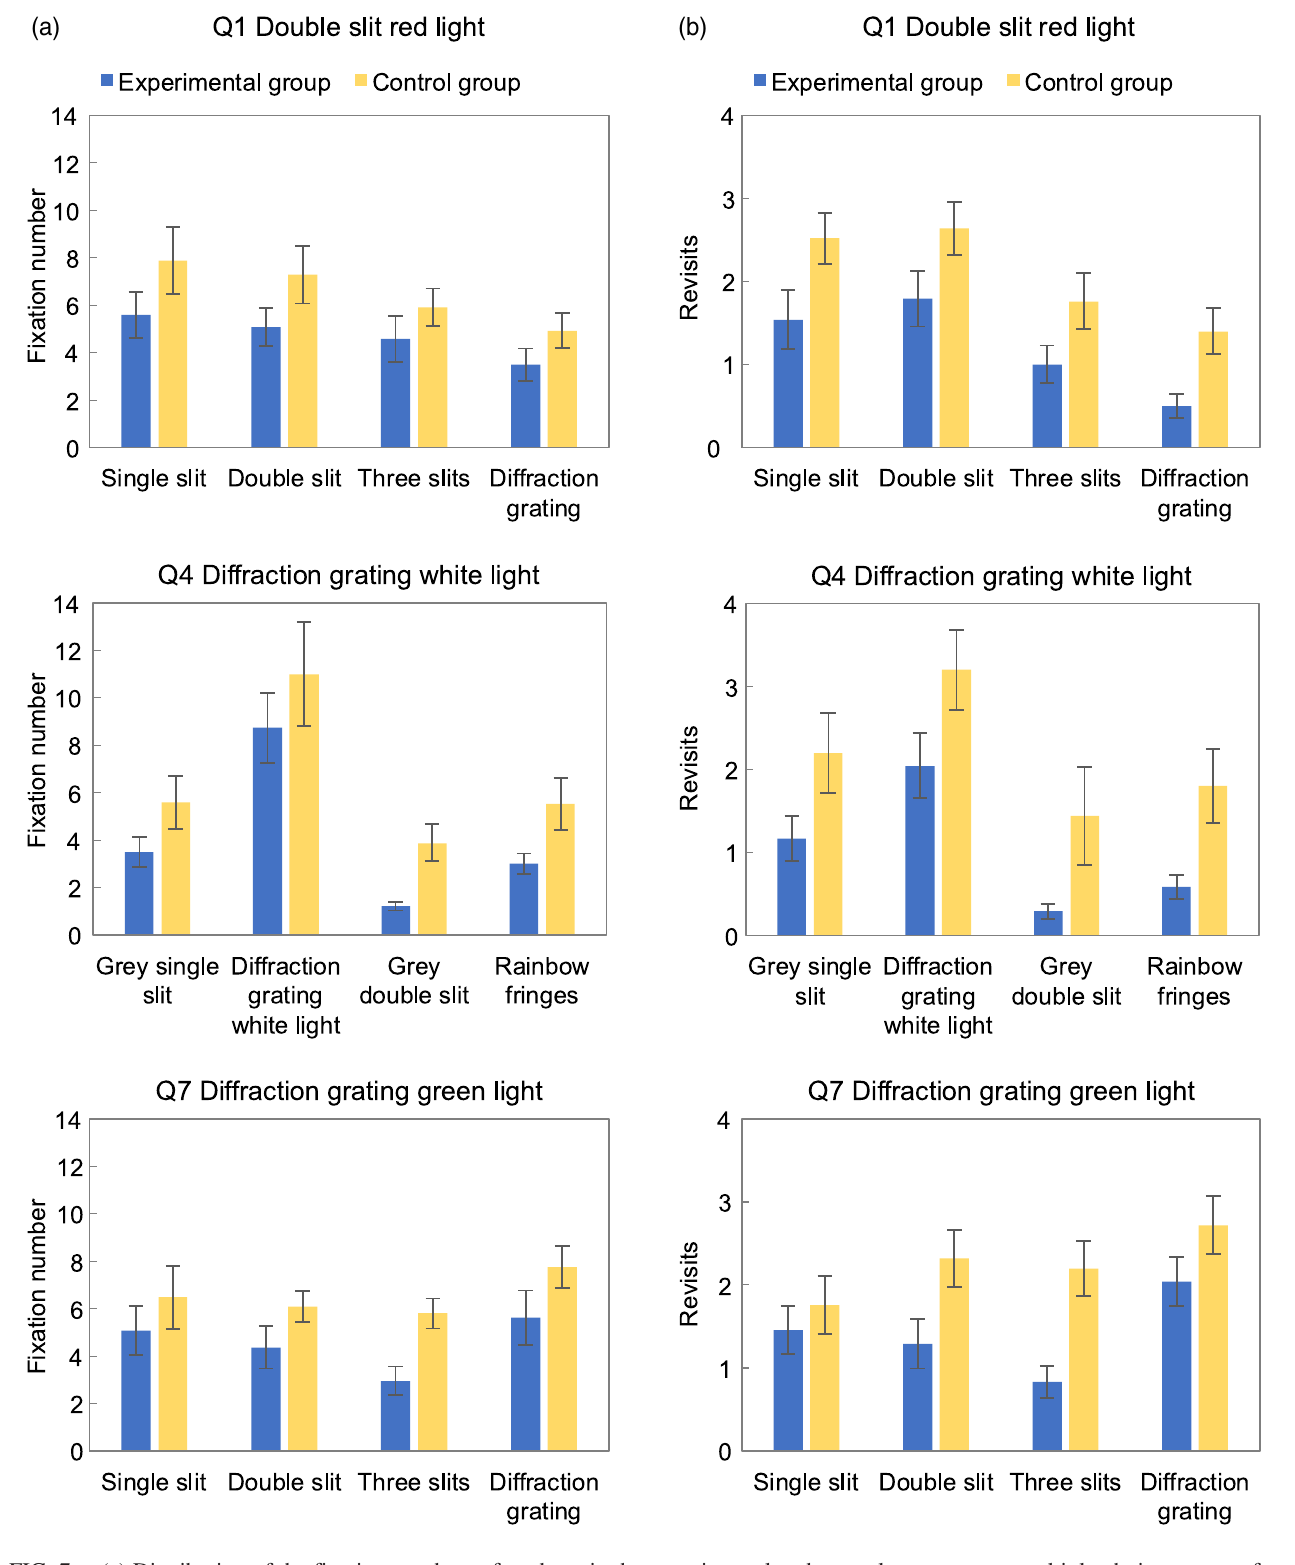
FIG. 7. (a) Distribution of the fixation numbers of students in the experimental and control group across multiple-choice patterns for three questions: double slit, Q4 (diffraction grating white light), and Q7 (diffraction grating green light). (b) Distribution of the number of revisits of students in the experimental and control group across multiple-choice patterns for the same questions. The error bars represent 1